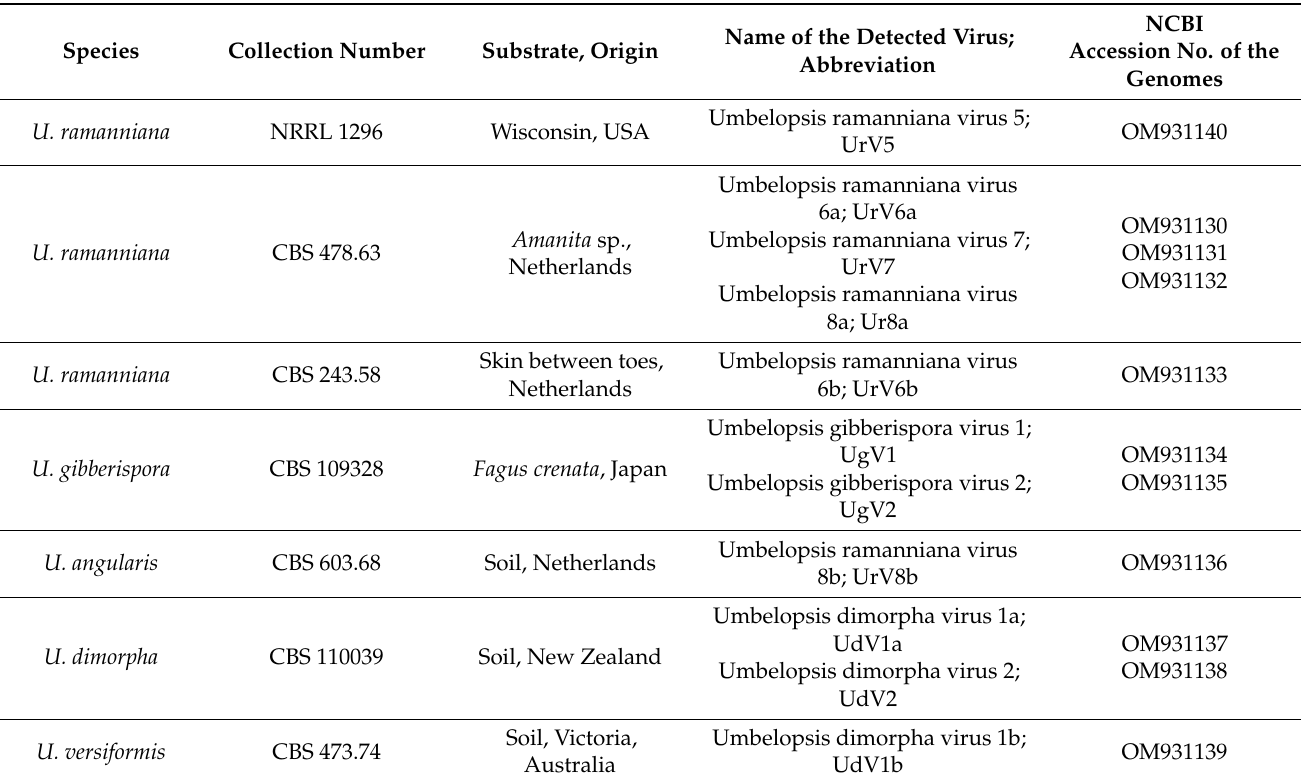
Table 1. Novel viruses identified in Umbelopsis